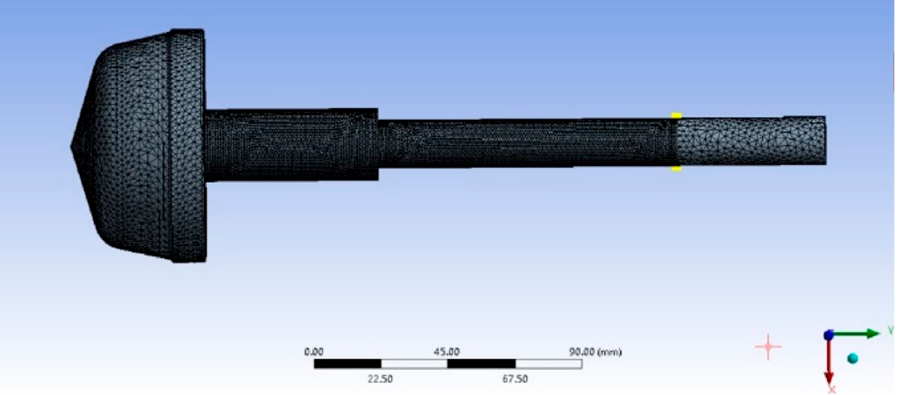
Figure 10. Fluid-structure interaction model of stem and valve core.